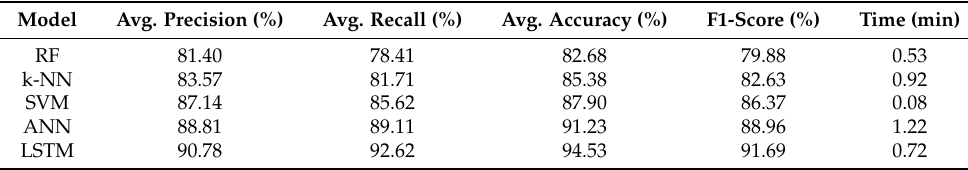
Table 3. Overall performance assessment using 2-fold cross-validation. Model